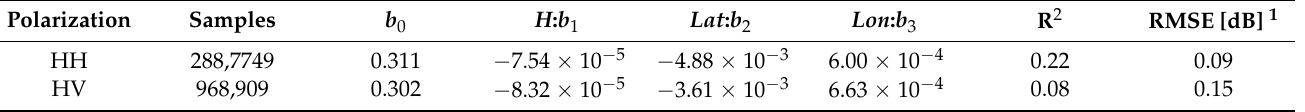
Table 1. Regression coefficient estimation.